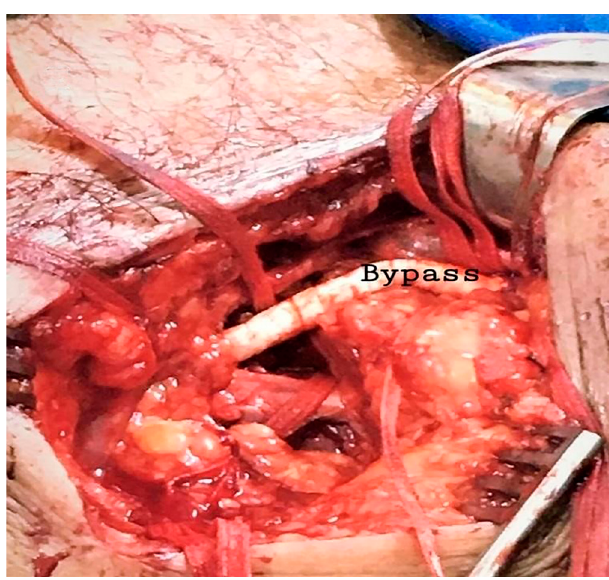
Fig. 3 –Intraoperative image after coronary subclavian